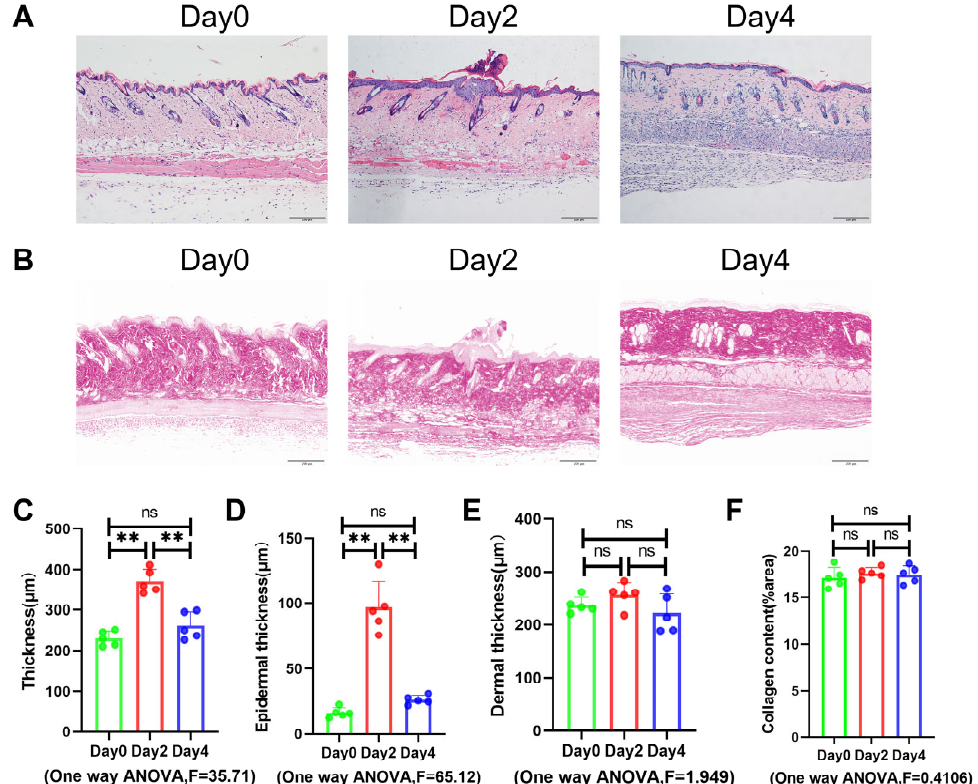
Figure 5. The rosacea-like skin lesions induced by LL-37 short-term administration mainly involved epidermal thickening without collagen hyperplasia, and the epidermis essentially returned to normal level after 2 days without LL-37 administration. ( A , C – E ) Hematoxylin-eosin (H&E) staining of lesioned skin (scale bar = 200 µ m). ( B , F ) Representative skin sections stained with Van Gieson staining (VG staining) (scale bar = 200 µ m). Data are presented as the mean ± SD; n = 5 for each group. ** p <